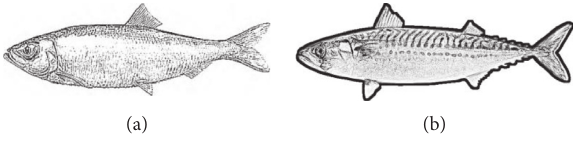
Figure 2: Herring and mackerel.